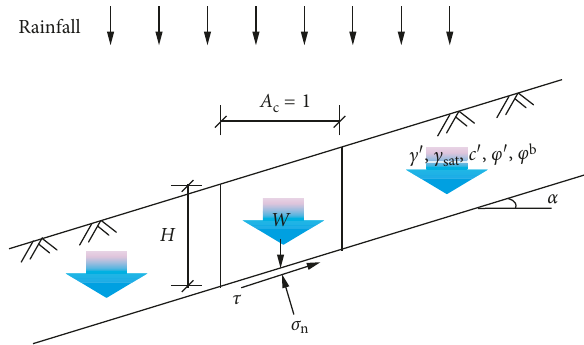
Figure 7: Infinite seepage model of unsaturated slope.